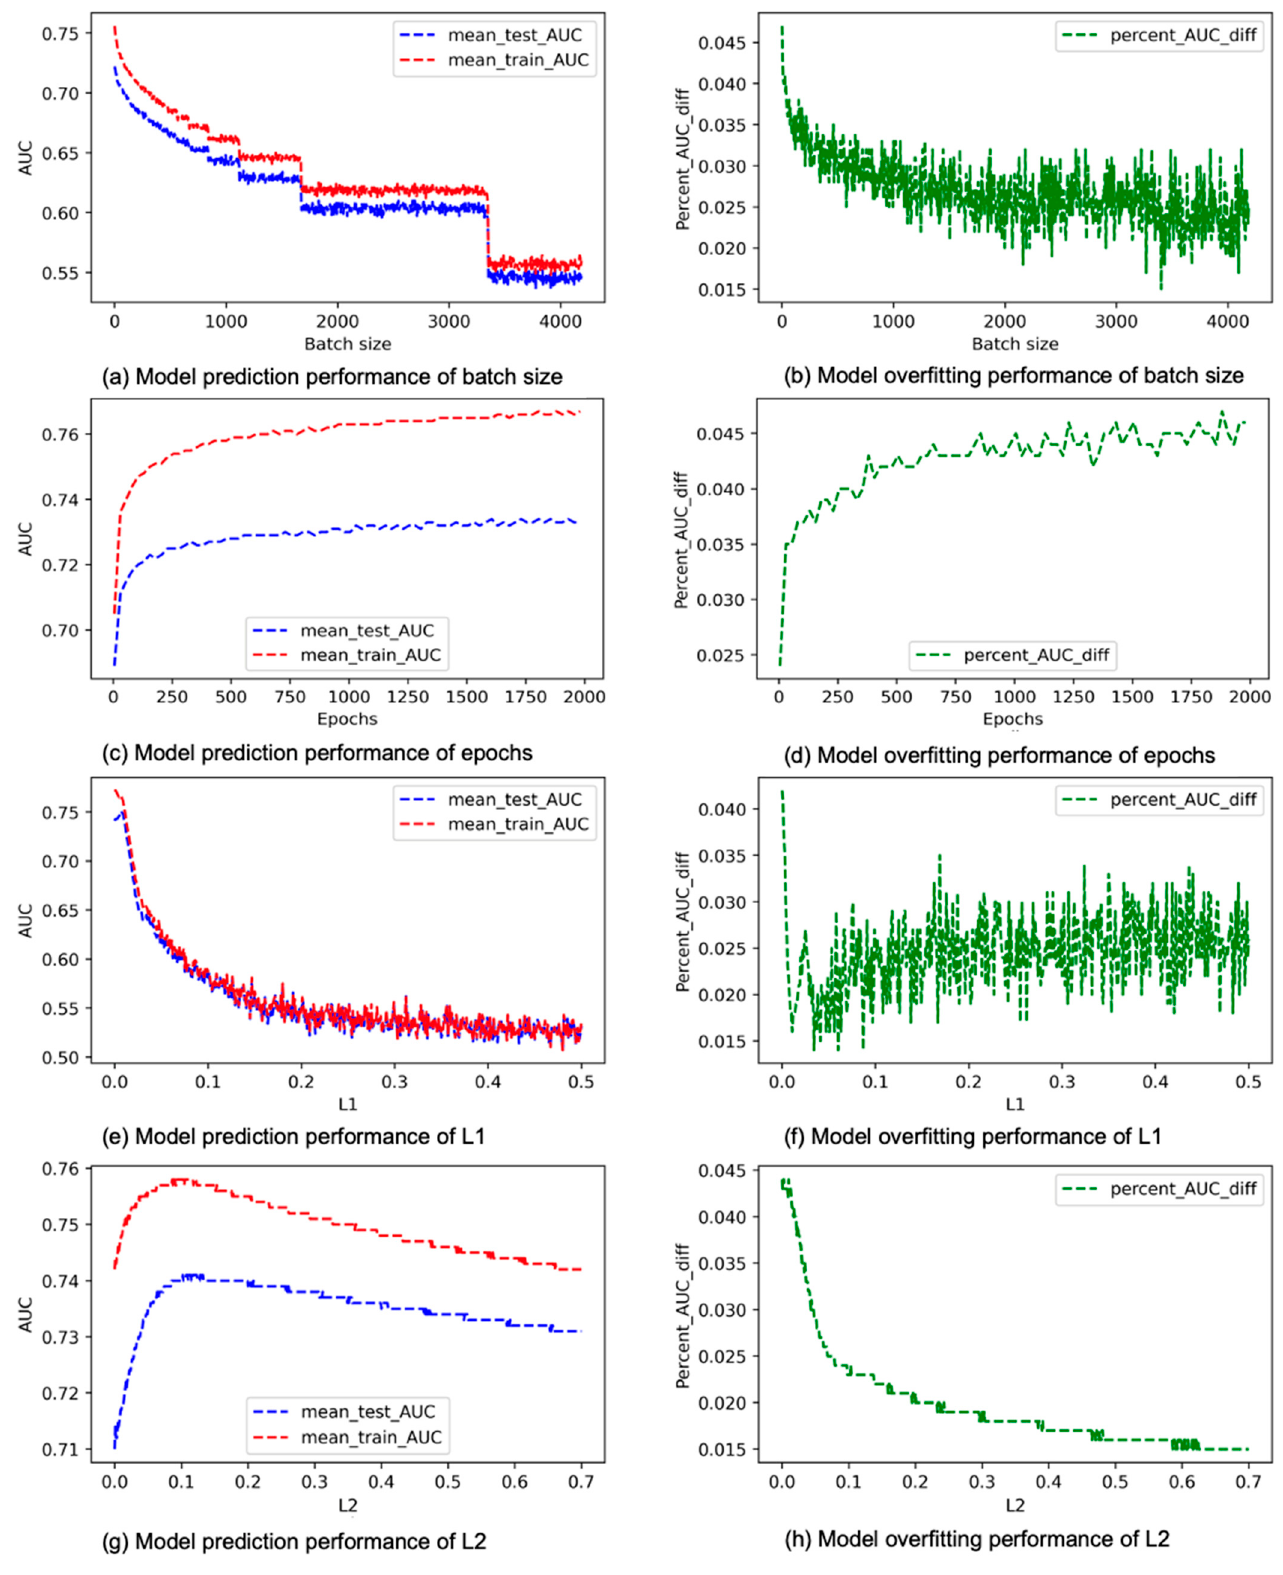
Figure 6. Average mean_train_AUC, mean_test_AUC, and percent_AUC_diff for batch size, epochs, L1, and L2.